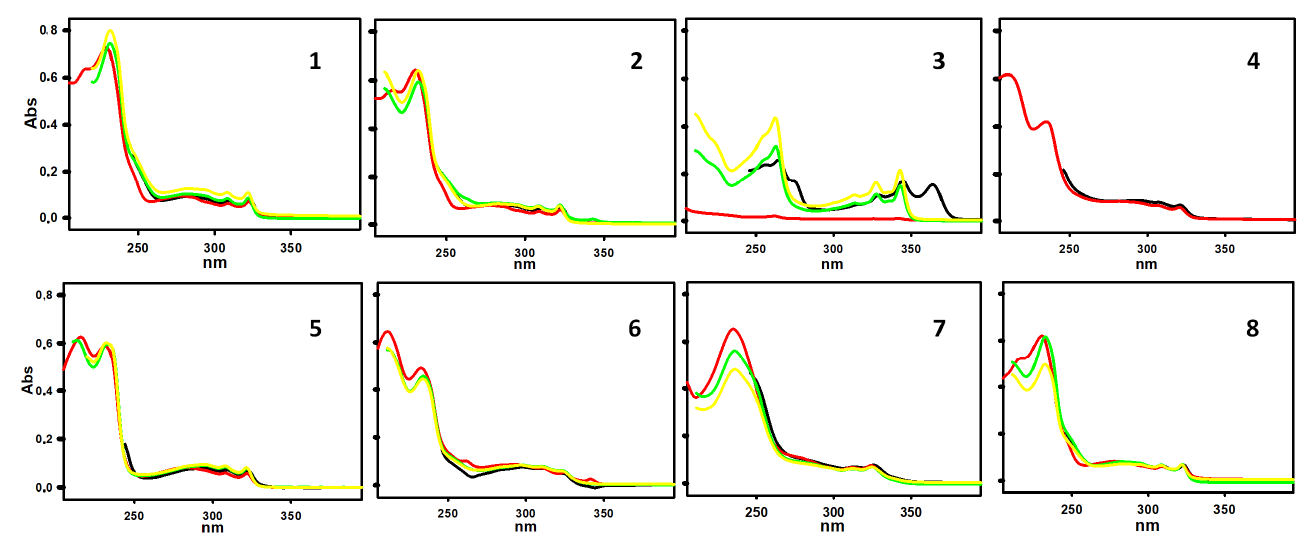
Figure 1. UV spectra of free quinolines ( 1 – 8 ) in n -hexane (red line), chloroform (black line), methanol (yellow line), and 2-propanol (green line). The concentration used for quinoline 4 is 5 × 10 − 5 M, fivefold the concentration of the quinolines in other panels.